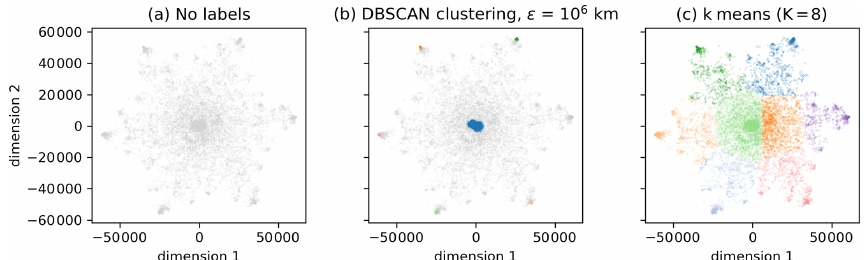
Figure 3. (a) A 2D embedding of the classical MDS method (see Sect. 3.2.2) of the trajectories. (b) Labels according to the DBSCAN result of Fig. 4. The six vortices and the jet are clearly visible as dense regions. Grey particles correspond to noise. (c) The k -means clustering result for K = 8; see Fig. 5 for the spatial clustering result of k